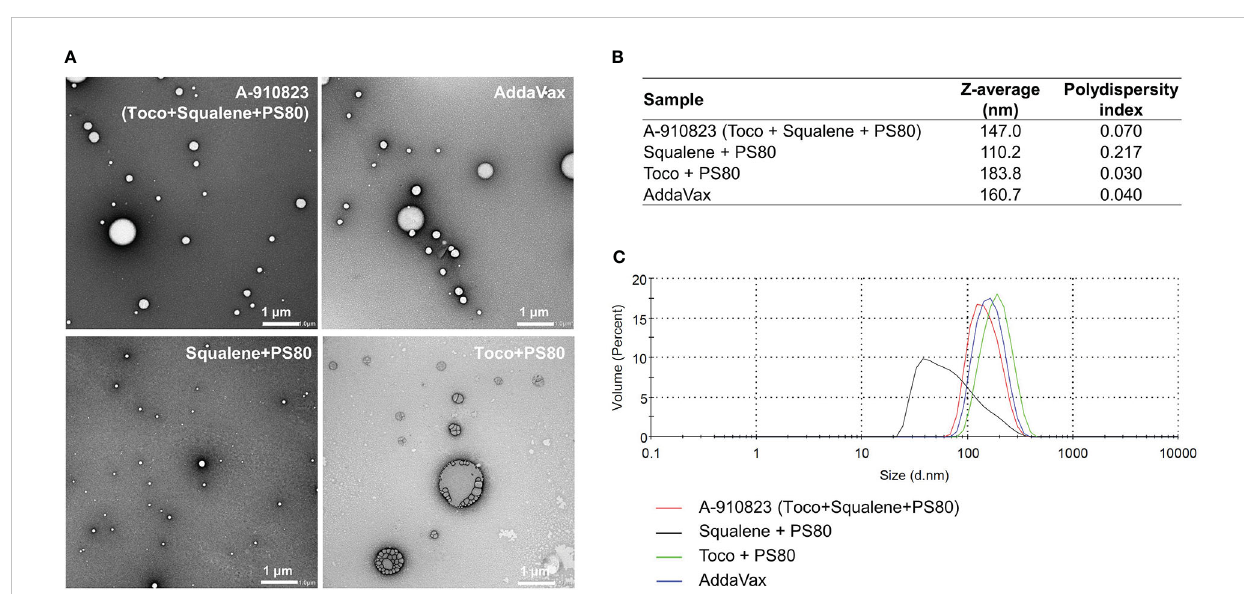
FIGURE 3 Preparation of A-910823 excluding each component. Physicochemical characterization of A-910823, AddaVax, A-910823 without a -tocopherol (squalene + PS80), and A-910823 without squalene (toco + PS80) determined by (A) TEM or (B-C) DLS. (B) The scale bars represent 1 µm. The hydrodynamic diameter (Z-average size) and polydispersity index of each adjuvant were measured. (C) The DLS histograms display the volume- based size distribution of A-910823, AddaVax, A-910823 without a -tocopherol (squalene + PS80), and A-910823 without squalene (toco + PS80).